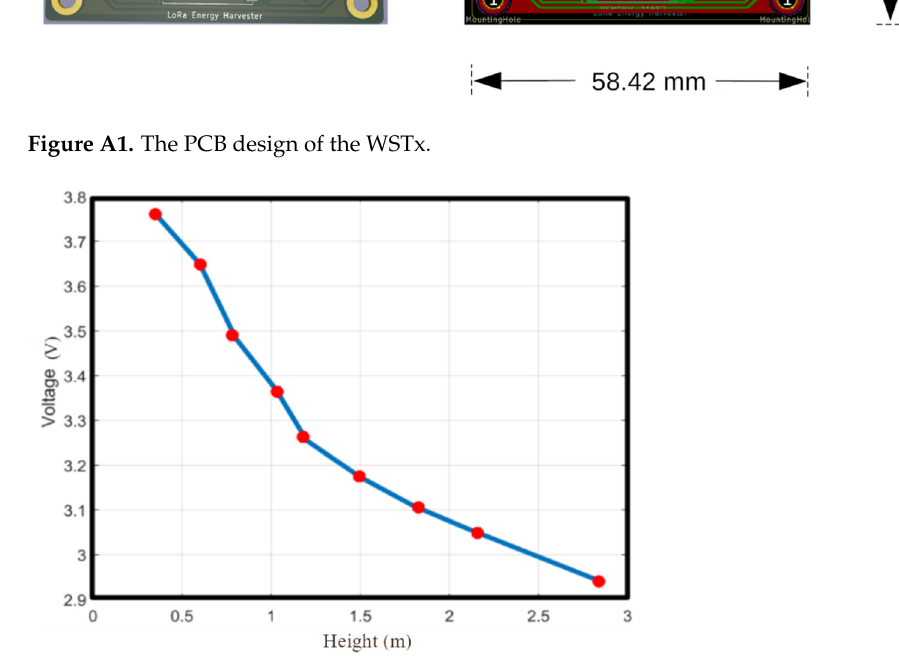
Figure A2. The measured relation between the solar panel’s height and the generated open-circuit voltage.